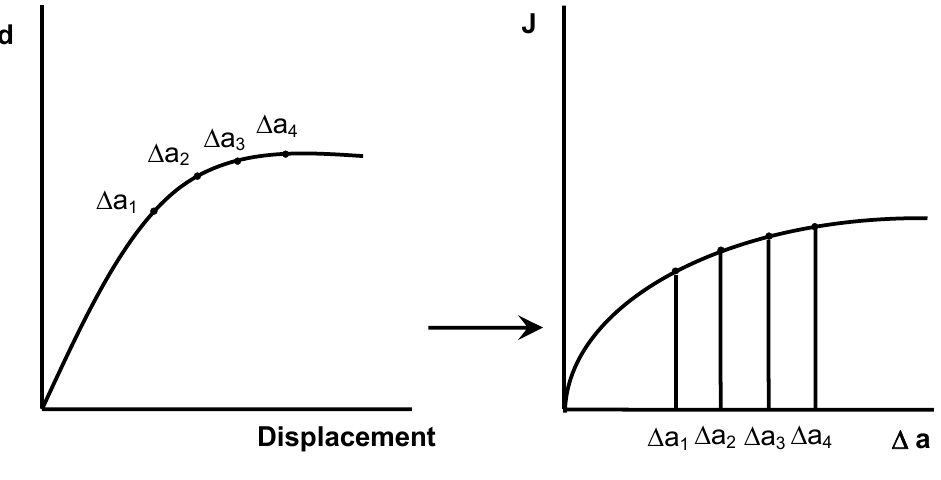
Figure 13. Determination J